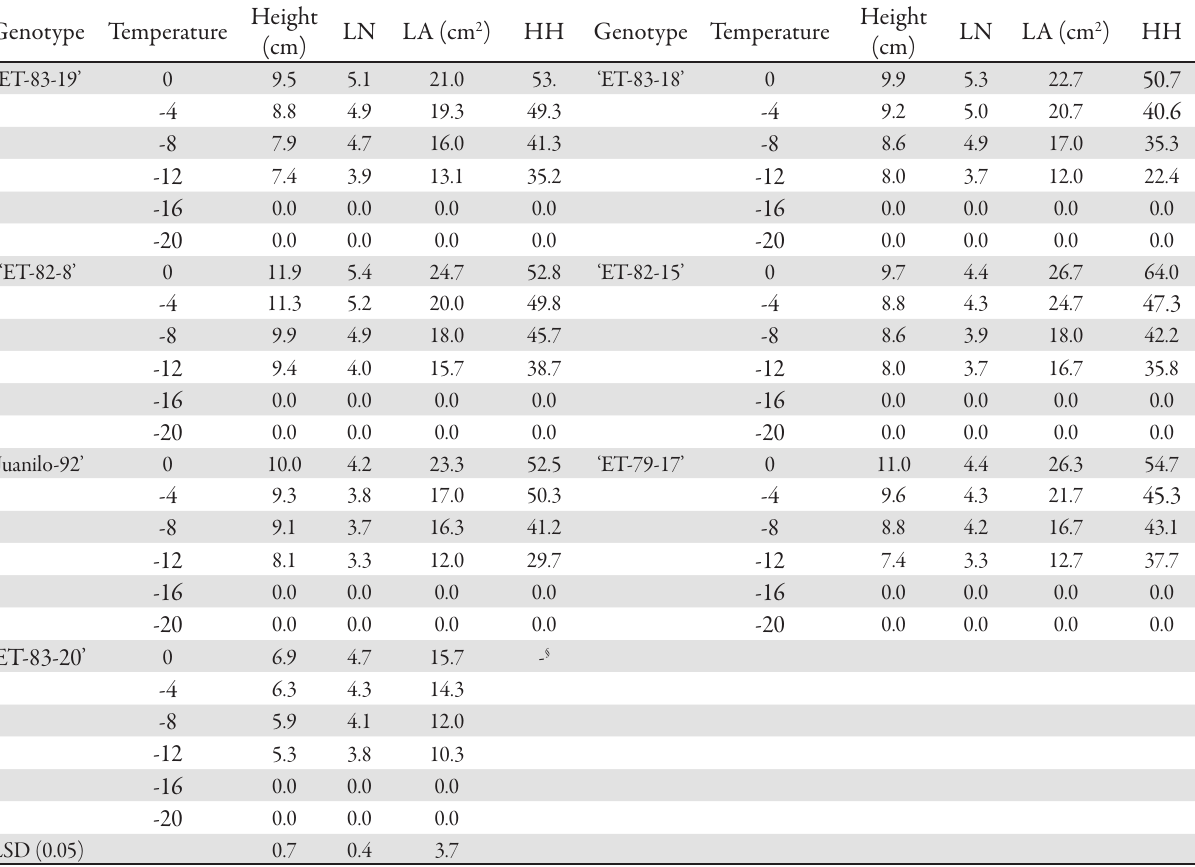
Tab. 5. The interactive effects of temperature and genotypes on various measured plant parameters exposed to freezing